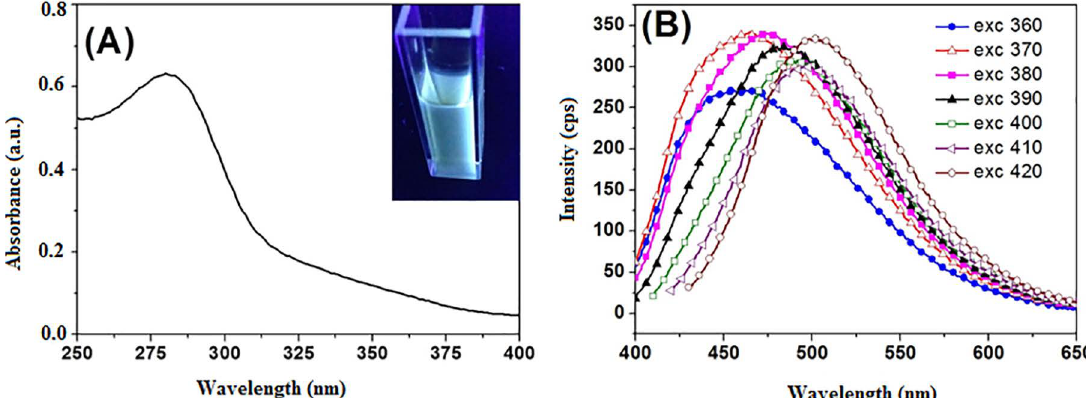
Figure 1. (A) UV-vis spectrum and (B) room temperature PL spectra at different excitation wavelengths of C-dots solution obtained at different time and temperature (18 h and 160 ºC) of hydrothermal